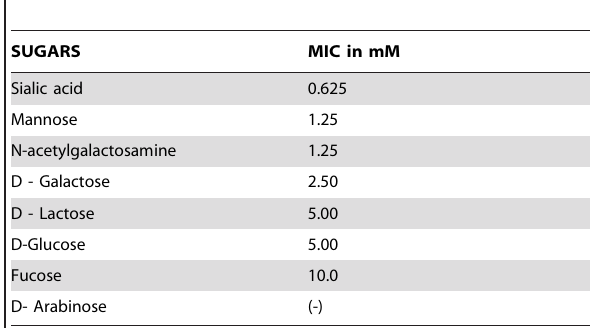
Table 1. Inhibitors and their Minimum concentration required for inhibition of hemagglutinating activity by